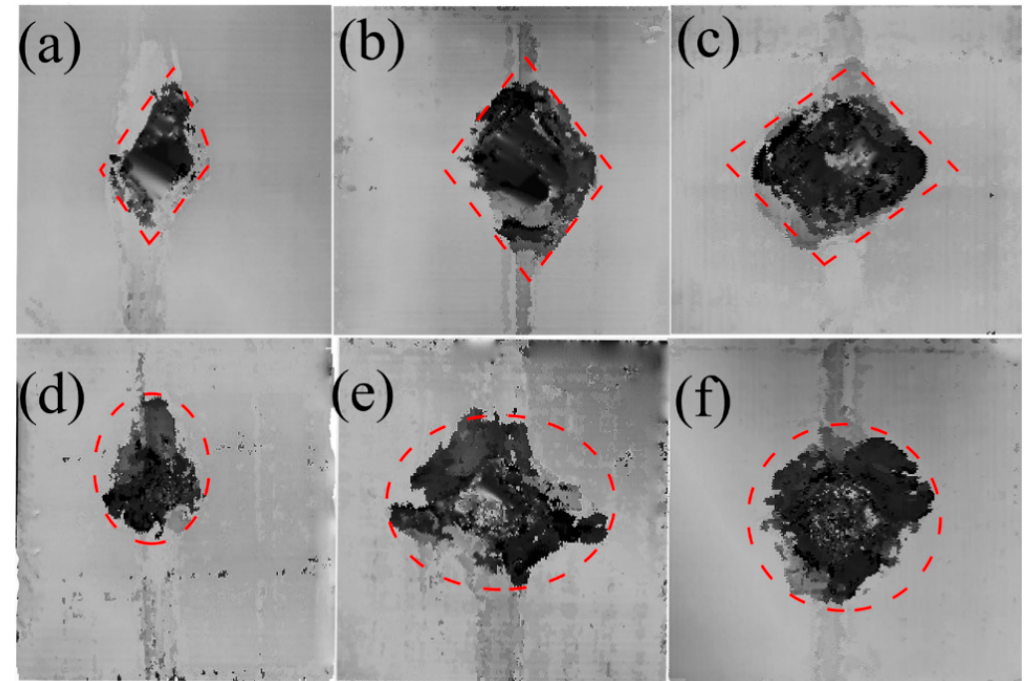
Figure 10. C-scan characteristic of the specimen after the impact velocities of ( a ) 45 m/s, ( b ) 68 m/s, and ( c ) 86 m/s in “dry” and of ( d ) 45 m/s, ( e ) 68 m/s, and ( f ) 86 m/s in “wet” for the sphere-ended projectile.